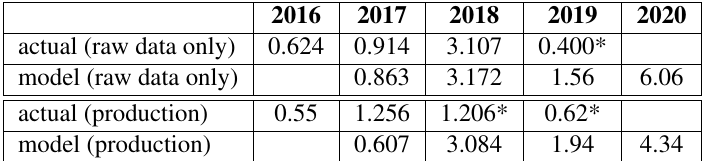
Table 1. GlueX Data volumes by calendar year. All values are in petabytes(PB). Most years include two run periods. *-marked values indicate partial numbers that are current as of mid-2019, but are expected to increase.